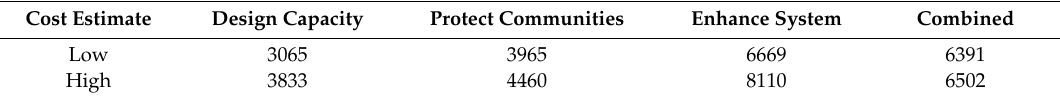
Table 2. Low and high cost upfront estimates ($M) for each of the CVFPP management strategies